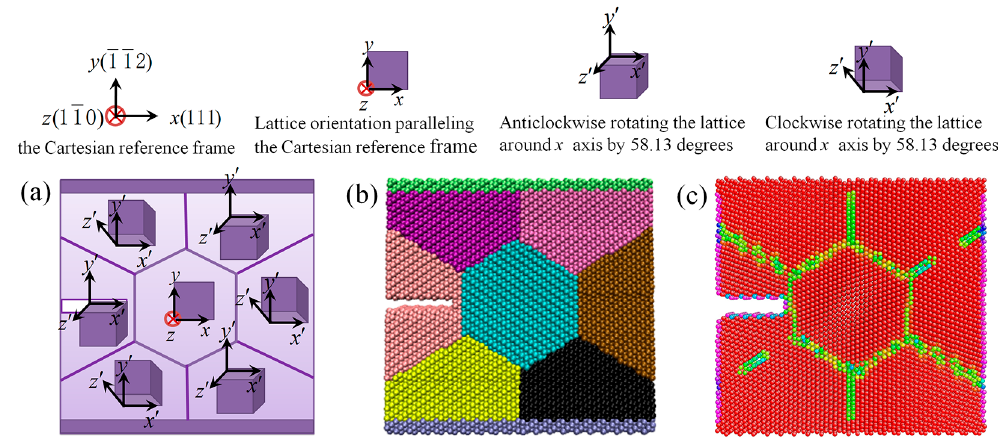
Figure 1. Models for nanoscale polycrystal nickel: ( a ) diagrams of grain orientations; ( b ) configurations before relaxation; ( c ) configurations after relaxation. before relaxation; ( c ) configurations after